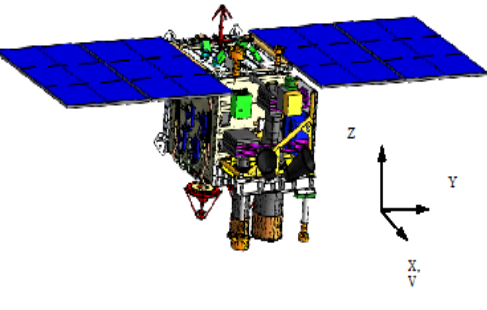
Figure 1. General view of “Canopus-V”